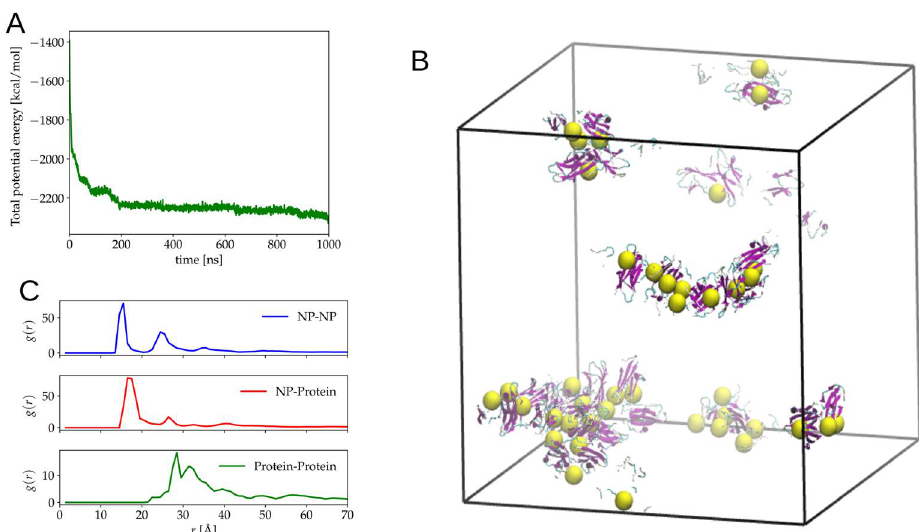
Figure 5. ( A ) Time evolution of total potential energy dynamic simulations using the MS model. ( B ) Snapshot of the final configuration. ( C ) The radial distribution function of the pairs NP-NP, NP-Protein, and Protein-Protein. Protein all-atom reconstruction was performed with PULCHRA [27].